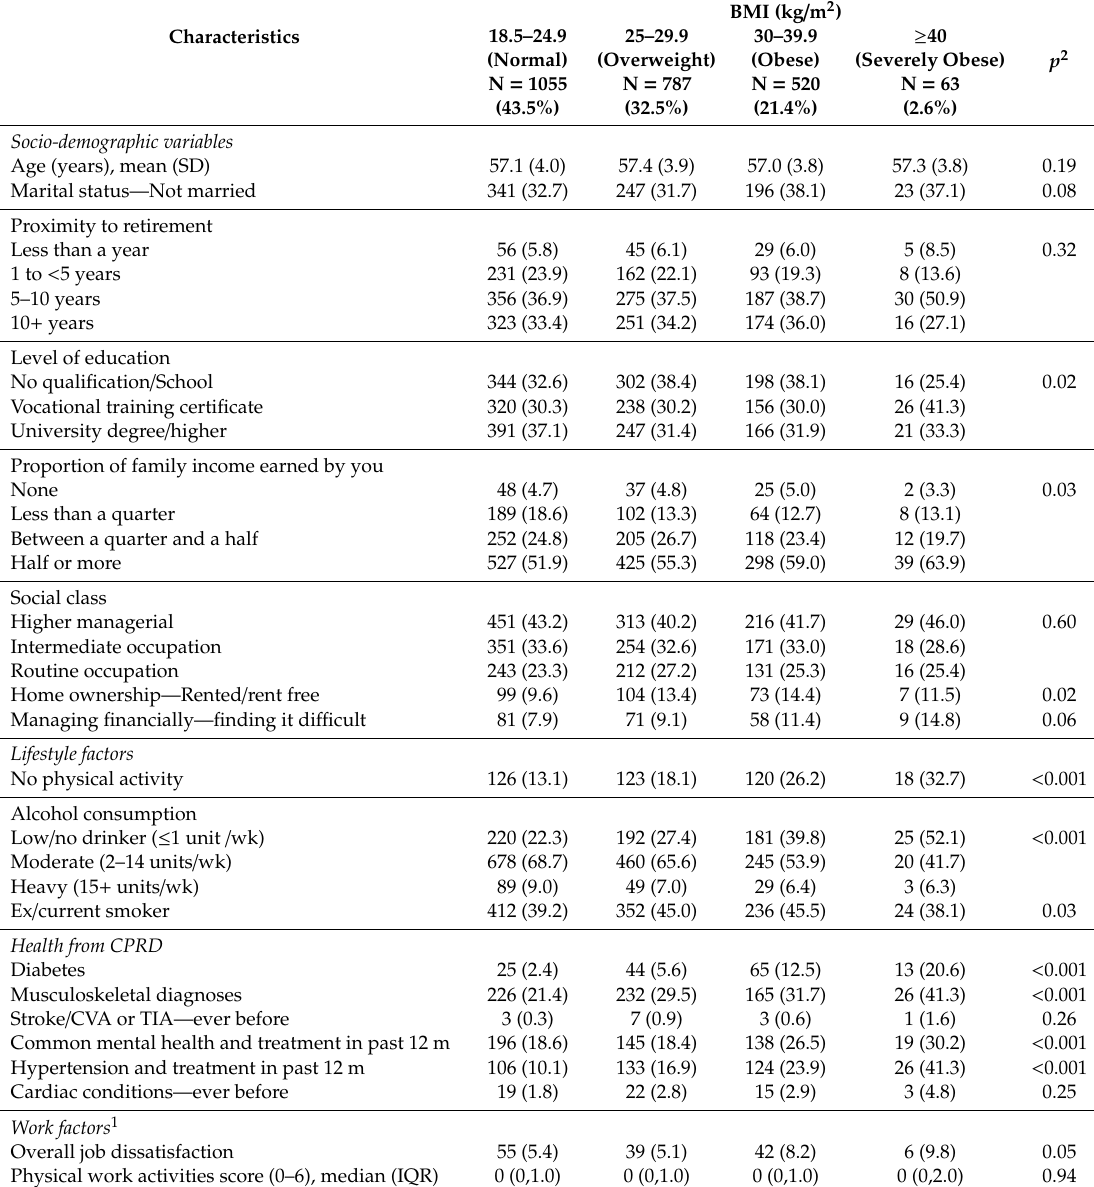
Table 2. Baseline characteristics of women, by categories of body mass index